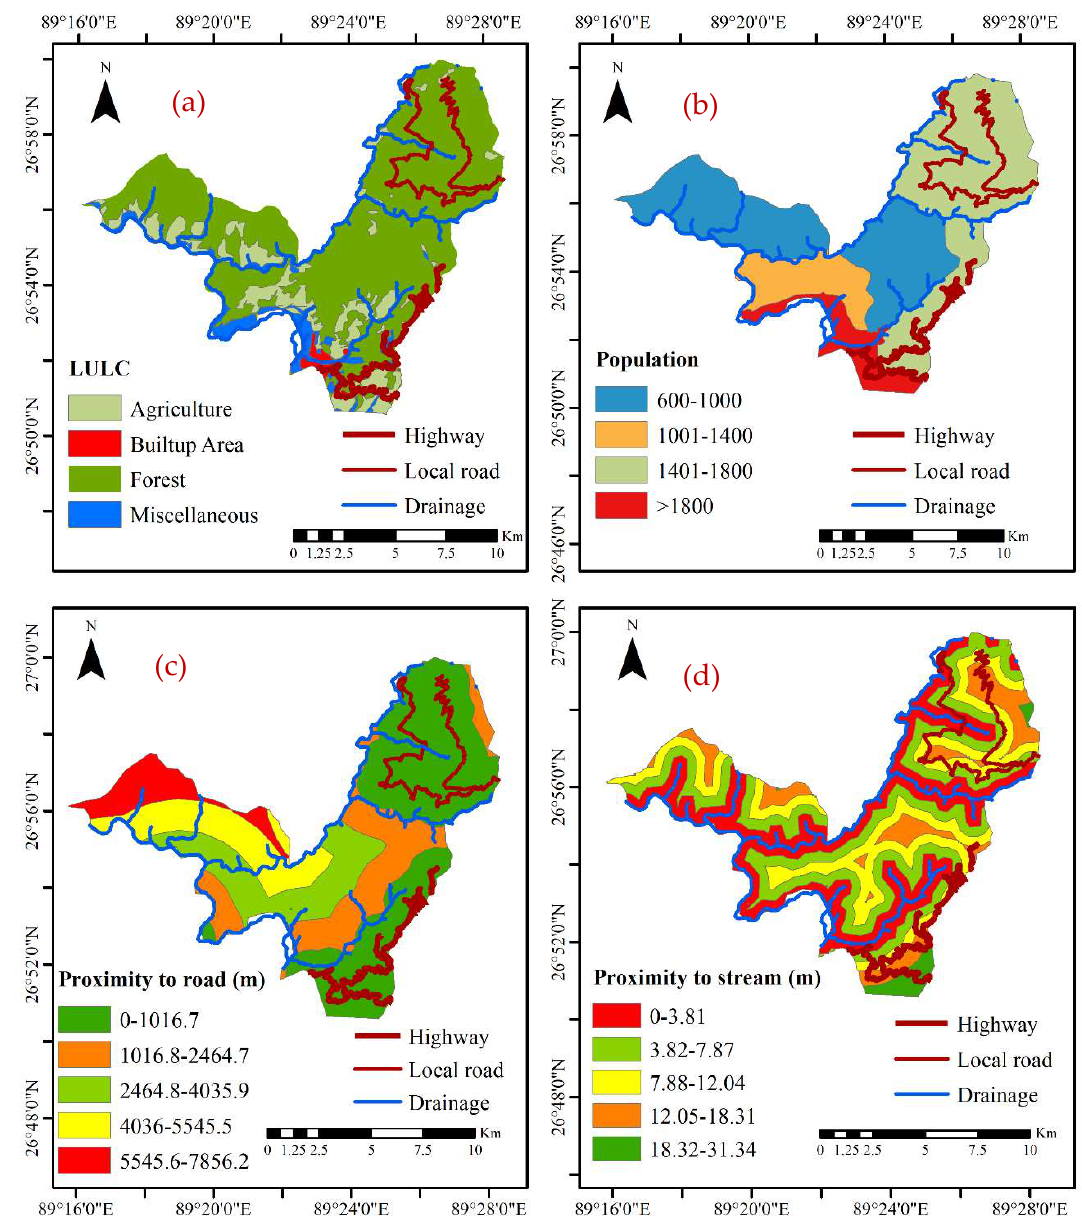
Figure 6. Landslide vulnerability factor maps ( a ) LULC, ( b ) population, ( c ) proximity to road, ( d ) proximity to stream.